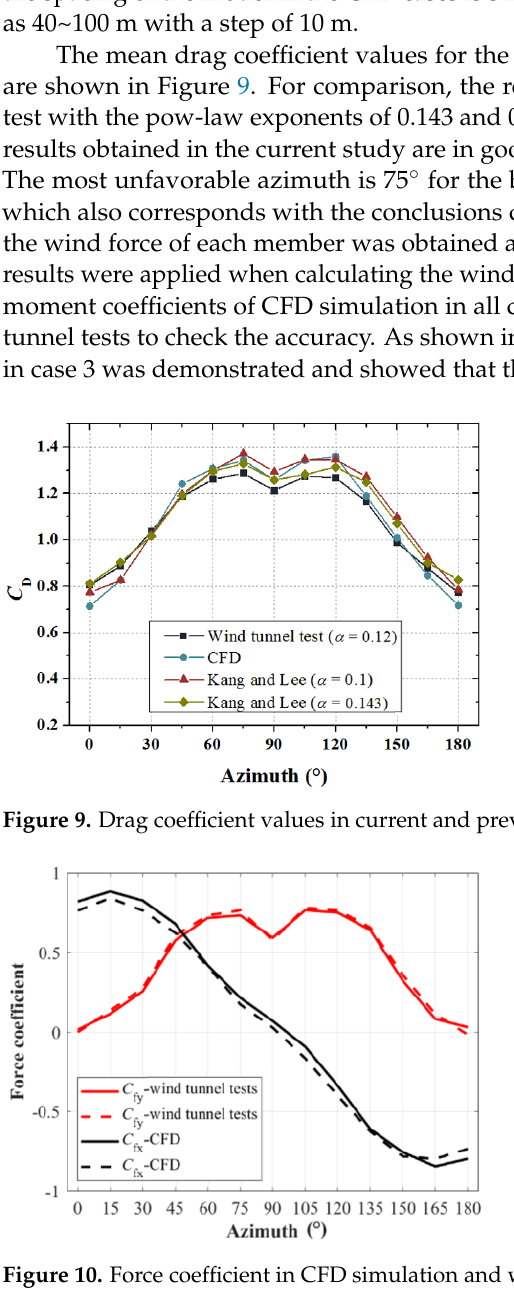
Figure 10. Force coefficient in CFD simulation and wind tunnel tests.